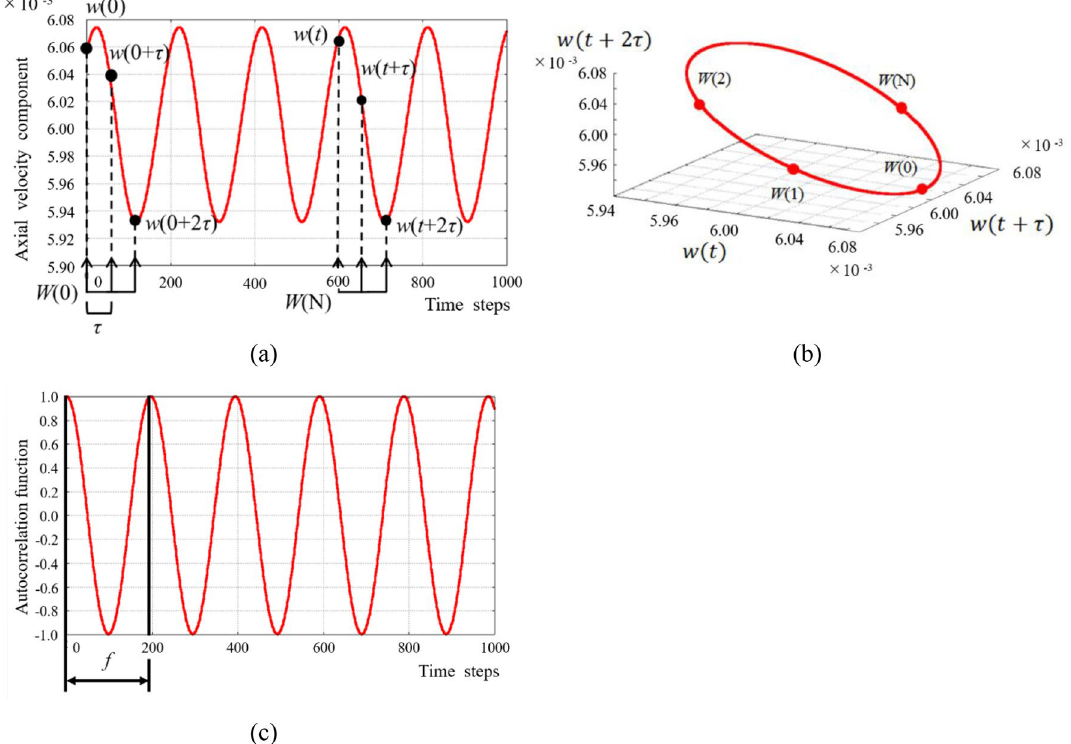
Fig. 6 Analytical methods based on autocorrelations: a is the three-dimensional embedding, b is the orbit of the attractor and (c) is the autocorrelation function of the sine